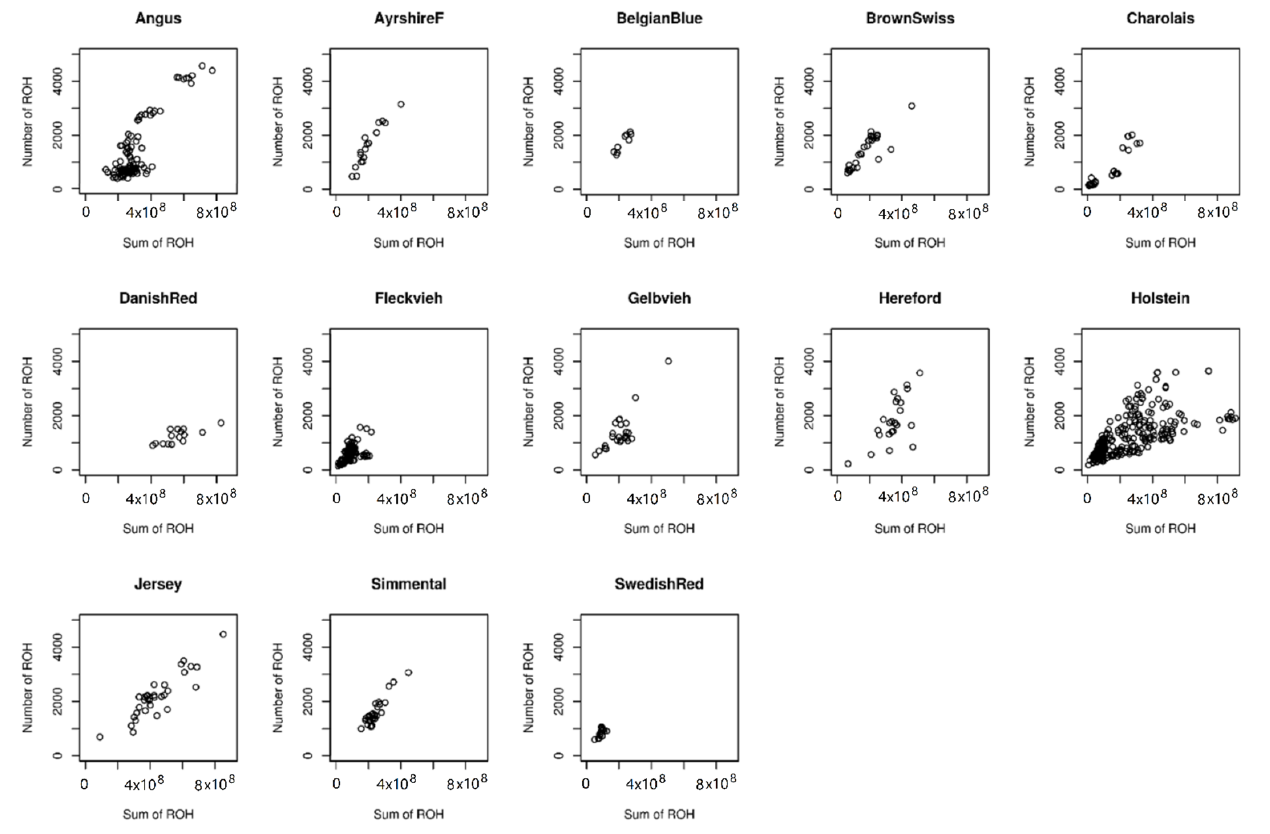
Figure 2. The number of ROH plotted against the sum of ROH in sequenced populations. The x axis shows the total length of ROH in bp. The y axis shows the total number of ROH in the genome. Each dot represents one individual.